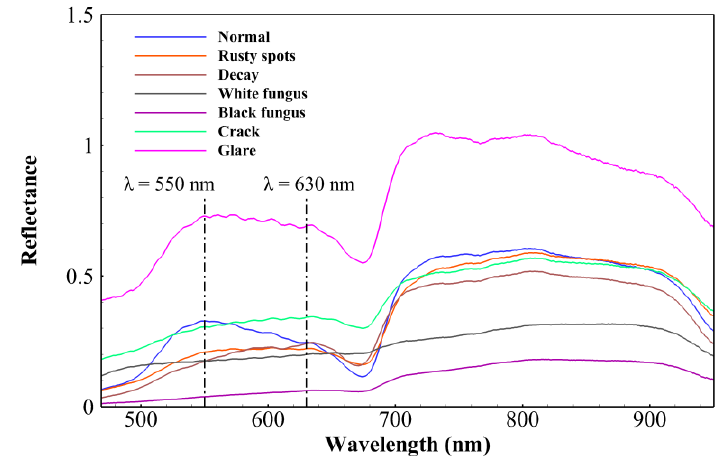
Figure 5. The averaged reflection spectra of common skin defects and glare of the jujube in the wavelength range of 468–950 nm.